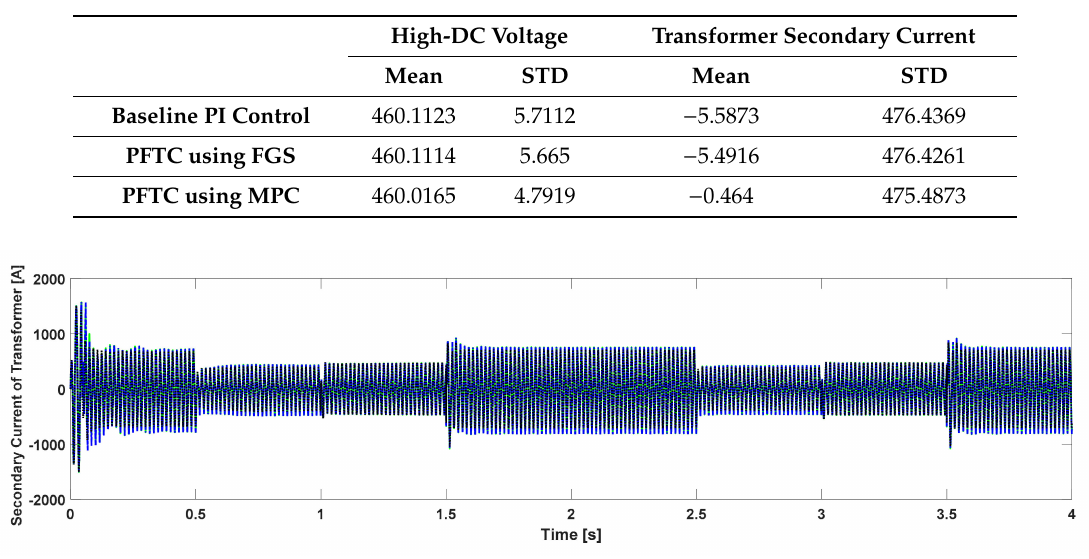
Figure 13. High-DC voltage during fault-free operation. Table 3. Quantitative performance comparison of controllers during fault-free operation.